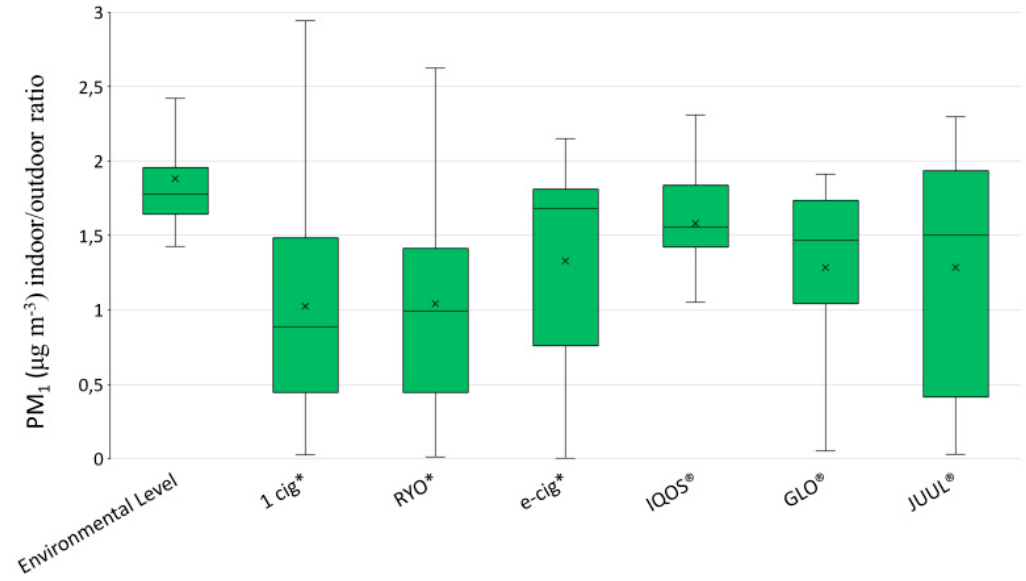
Figure 6. Indoor/outdoor ratios of PM 1 levels for environmental level and during the smoking/vaping sessions of each device. * 1 cig = one conventional cigarette; RYO = “Rolled your own” hand-rolled cigarette; e-cig = electronic cigarette.